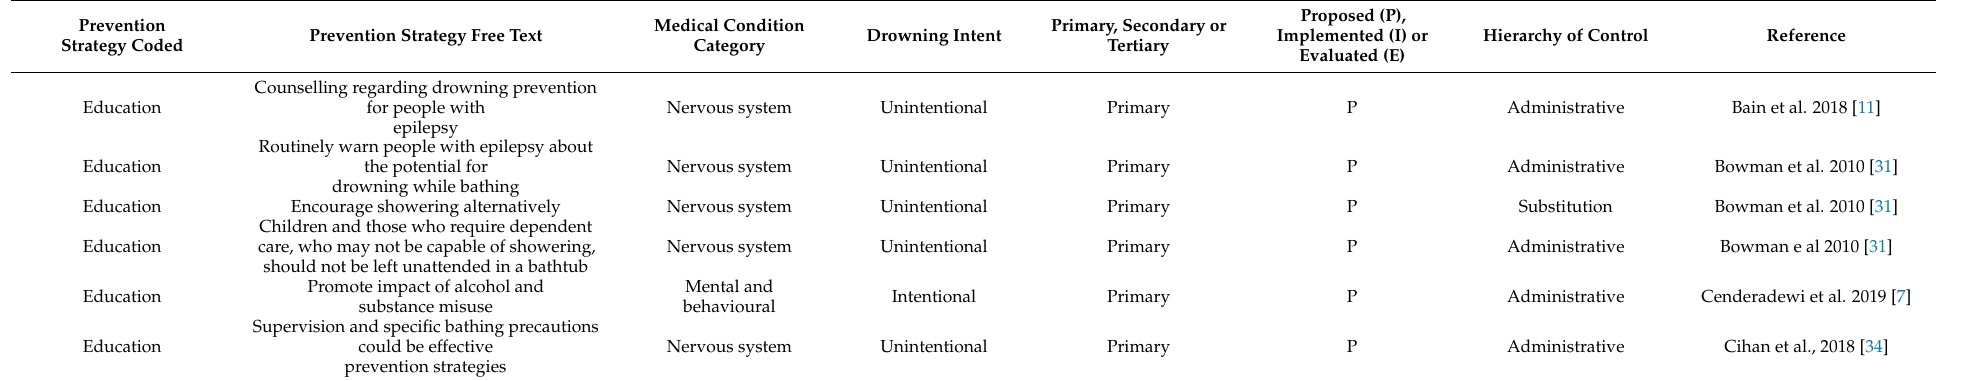
Table 8. Drowning prevention strategies documented in included literature by medical